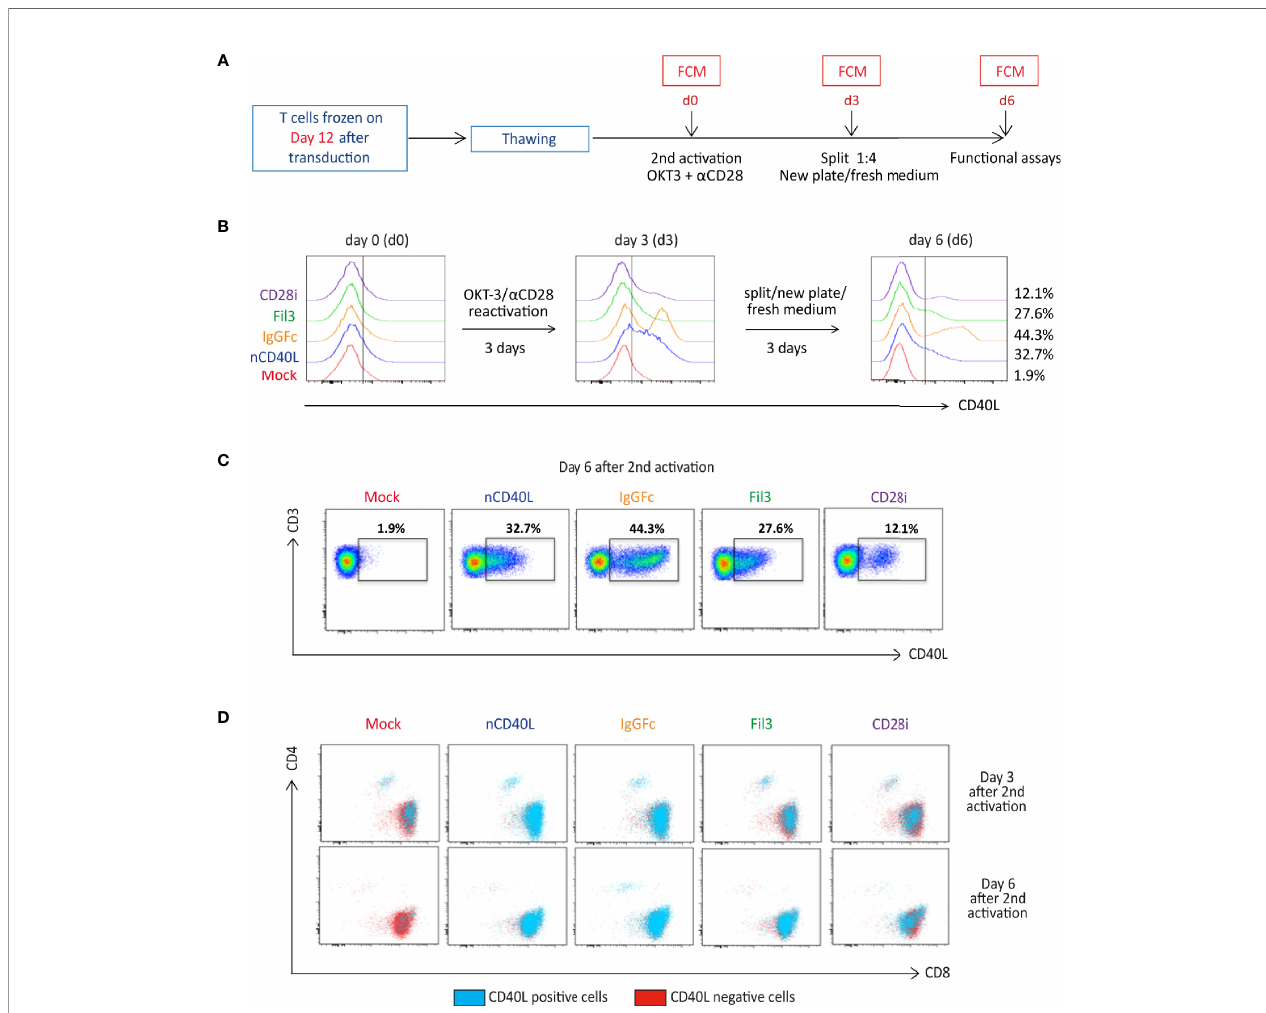
FIGURE 5 | CD40L:CD28 CSP surface expression is regulated by anti-CD3/CD28 T cell activation. (A) Timeline depicting the re-activation of transduced T cells, which were frozen on day 12 after CSP transduction. T cells were thawed and re-activated using anti-CD3 plus anti-CD28 antibodies and 100 U/ml IL-2 for 3 days, then transferred to a new plate without antibodies in fresh medium plus 100 U/ml IL-2 for 3 additional days to allow downregulation of endogenous CD40L expression on Mock-T cells. (B) Histograms showing CD40L surface expression (identifying the CD40L:CD28 CSPs, the transduced native CD40L protein and the endogenously expressed CD40L) by fl ow cytometry after thawing and every third day after re-activation. (C) Gated CD40L-positive CD4 and CD8 cells within the live, single, CD3 + population are shown in dot plots as the blue population superimposed on the CD40L-negative T cells shown in red. Mock-transduced T cells were used as negative control and T cells transduced with the native CD40L (nCD40L) sequence are the reference against the CD40L:CD28 CSPs. (D) Percentage of live, single, CD3 positive cells are shown in dot plots measured 6 days after re-activation of CD40L:CD28 CSP-transduced T cells. This stimulation was performed for each B cell and DC assay, as well as CD28 signaling assay, thus at least 10 times. The exact number of repeats is listed with each of these